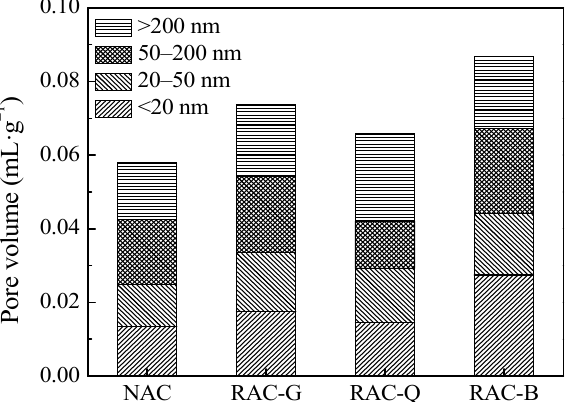
Figure 9. The volume of different pores in the mortar in the concrete.